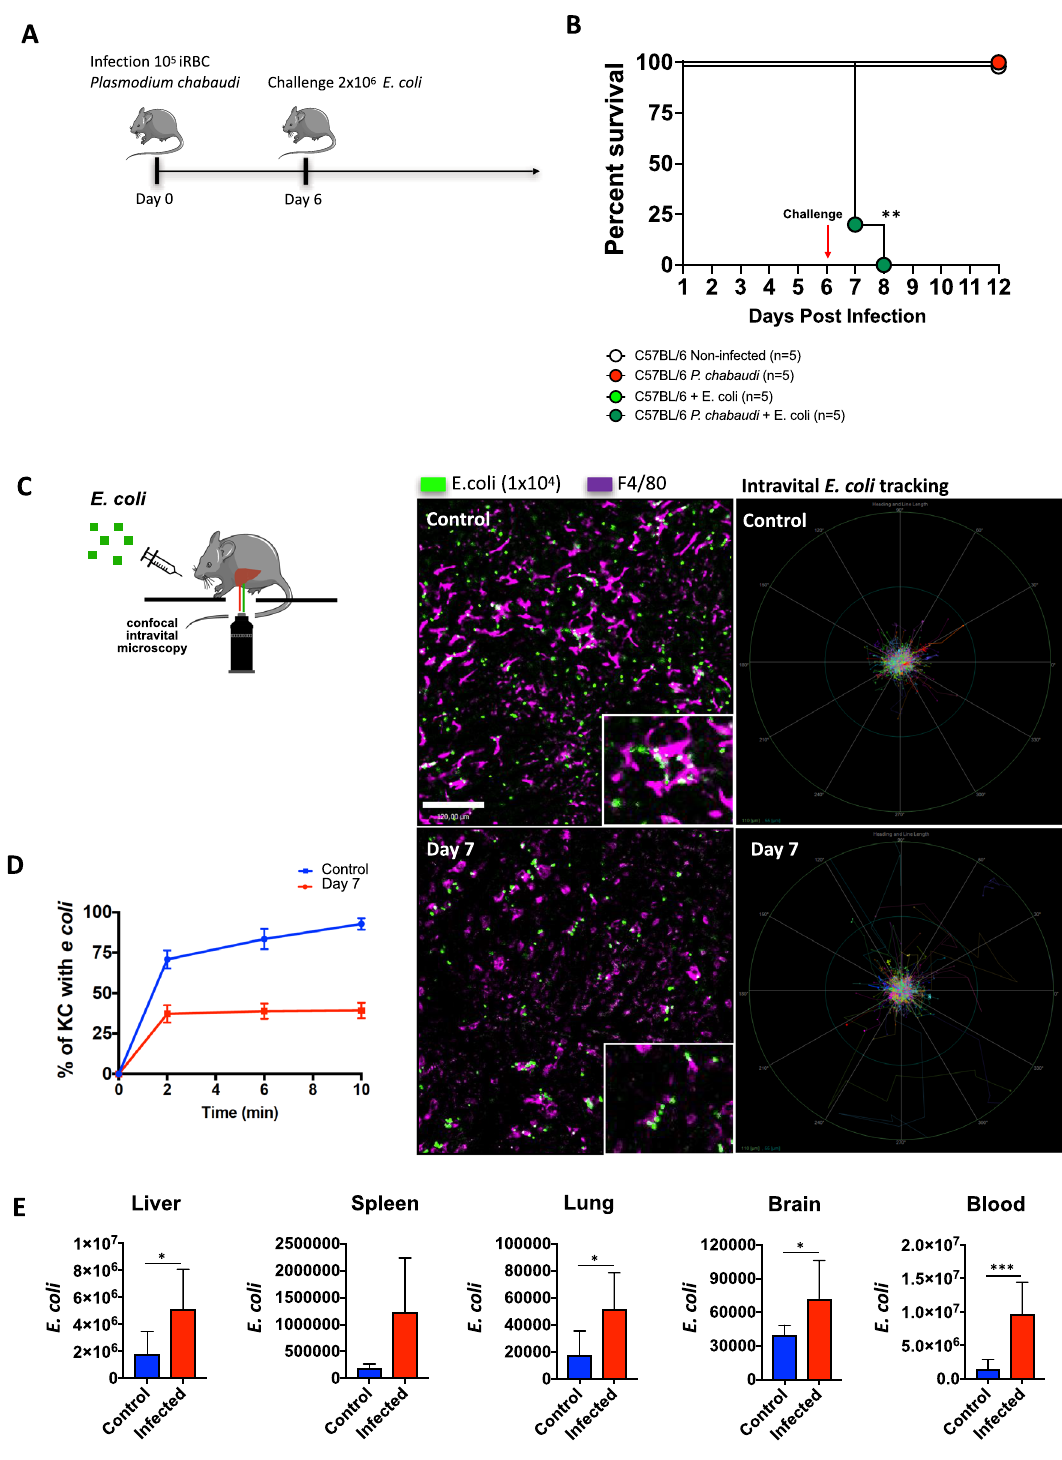
Figure 8. P. chabaudi infection leads to reduced ability to fight bacterial infection. ( A ) Experimental protocol of E. coli challenge. The scheme was partly generated using Sevier Medical Art, provided by Sevier, licensed under a Creative Commons Attribution 3.0 unported license. ( B ) Percent survival after 6 days of infection followed by E. coli challenge. (Log-rank test, ** p < 0.01) ( C ) Liver confocal intravital microscopy of KCs (purple; anti-F4/80) and GFP- E. coli (green). Digital tracking of E. coli displacement within liver sinusoids. ( D ) Digital quantification of Kupffer cells percentage with E. coli across the time (n = 4). ( E ) CFU of E. coli GPF in liver, spleen, lung, brain and blood (control n = 8, infected n = 4). The data shown are representative of 3 independent experiments. Statistical significance comparing infected and non-infected mice (Student’s t test, * p < 0.05, *** p <